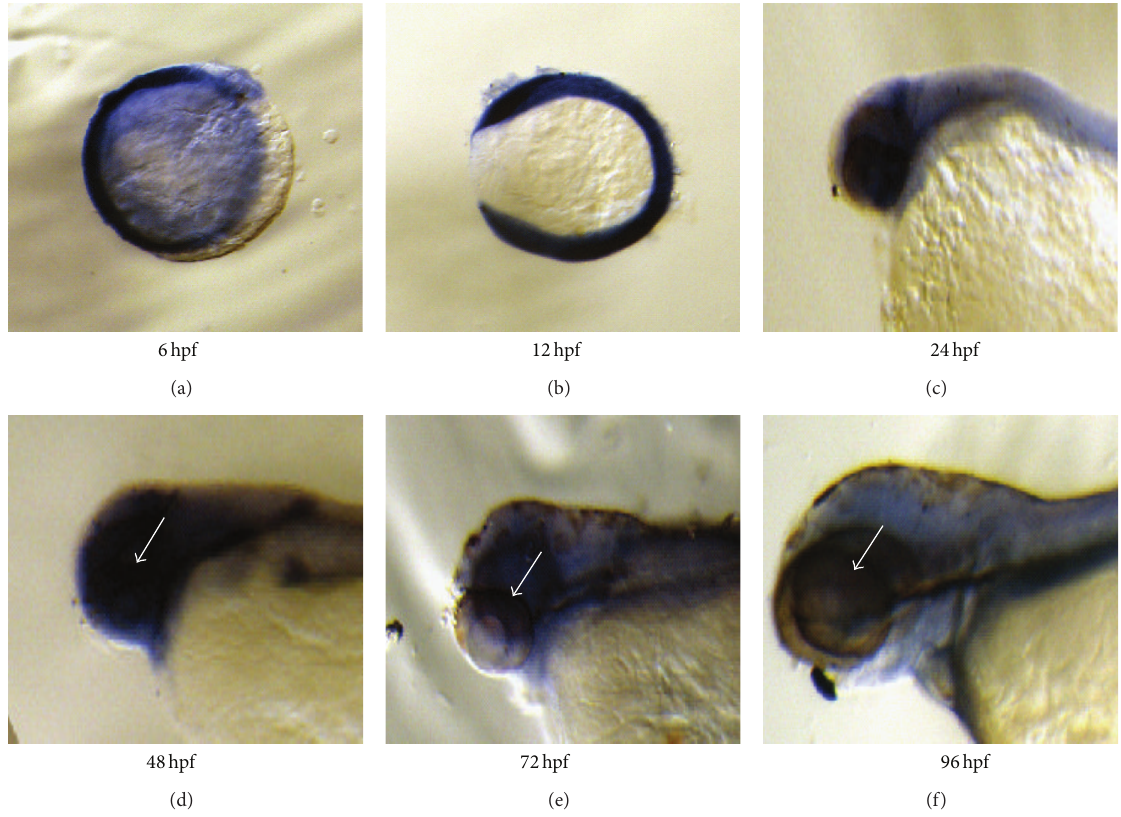
Figure 1: Whole mount in situ hybridization revealed a ubiquitous expression of the Snrnp200 gene in all developmental stages of zebrafish. The 6 time points include 6 hours postfertilization (hpf) (a), 12hpf (b), 24 hpf (c), 48hpf (d), 72 hpf (e), and 96 hpf (f). Six embryos from each time point were collected for the experiment, and the Snrnp200 signal in retina was indicated by white arrows